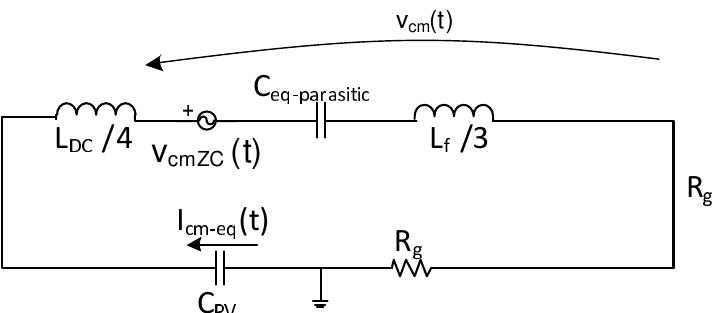
Figure 7. Equivalent common mode circuit in Zero state condition.